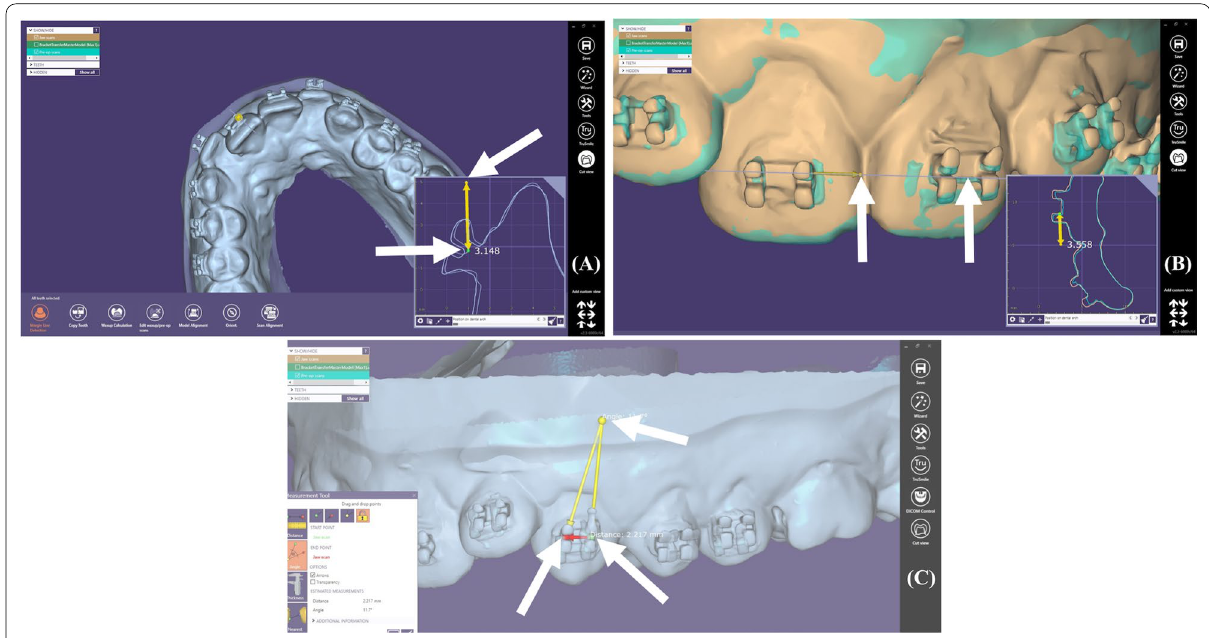
Fig. 6 Different measurements. A Height. B Mesio-distal positioning. C Angulation